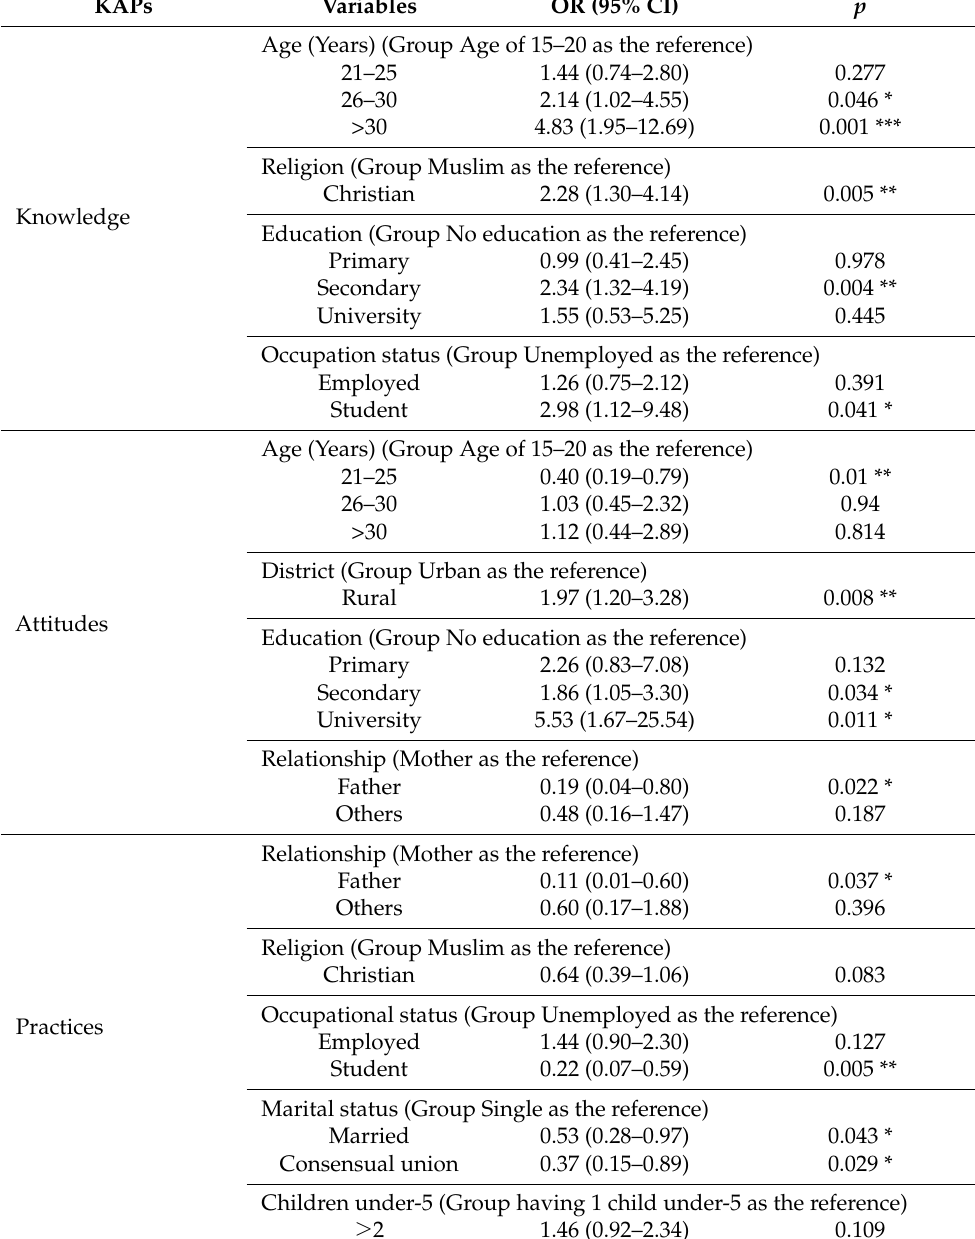
Table 4. Multivariate logistic regression analysis of KAPs ( n =